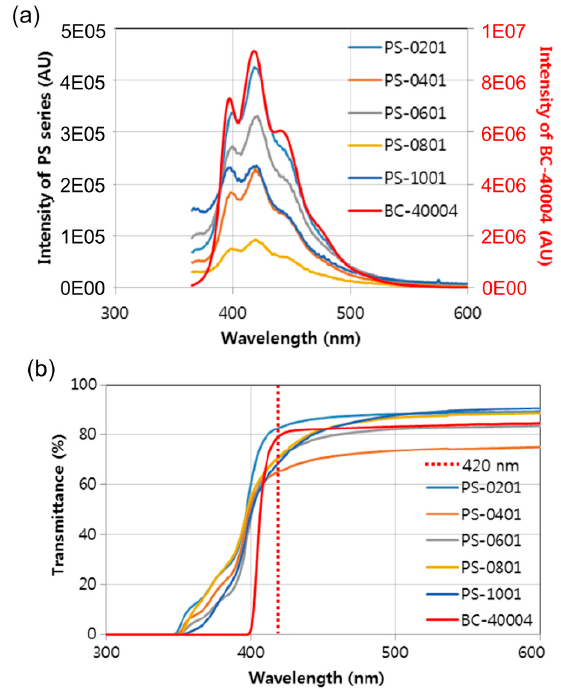
Figure 27. BC-400 and fabricated plastic scintillators: ( a ) emission intensity with wavelength and ( b ) transmittance with wavelength [93,94].